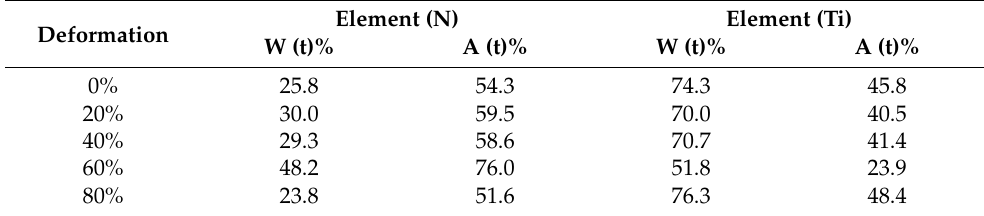
Table 1. EDS Energy Spectrum Test Data of Special Points After Nitriding Series of Deformed Alloys.